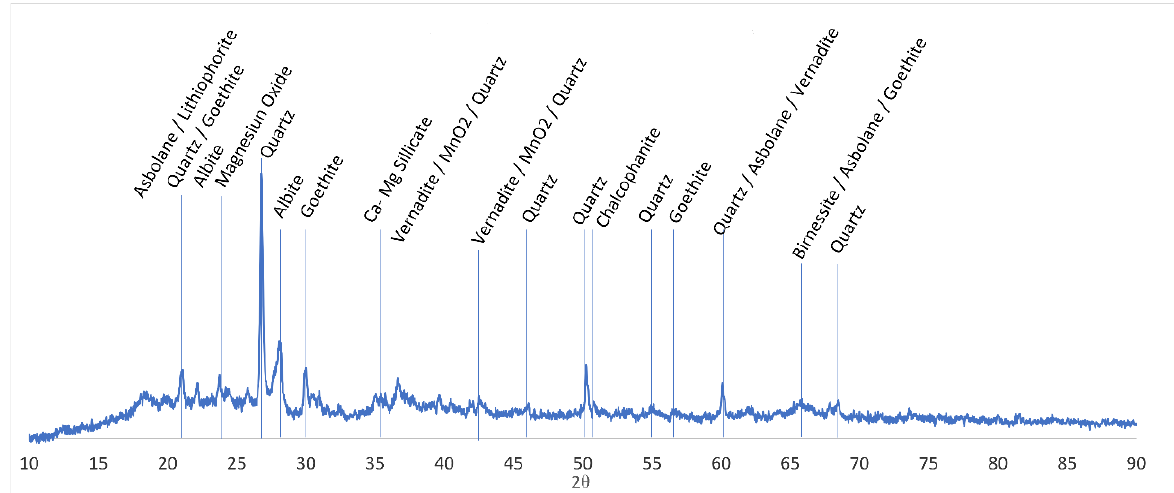
Figure 2. XRD pattern of a raw PMMN with identified peaks.